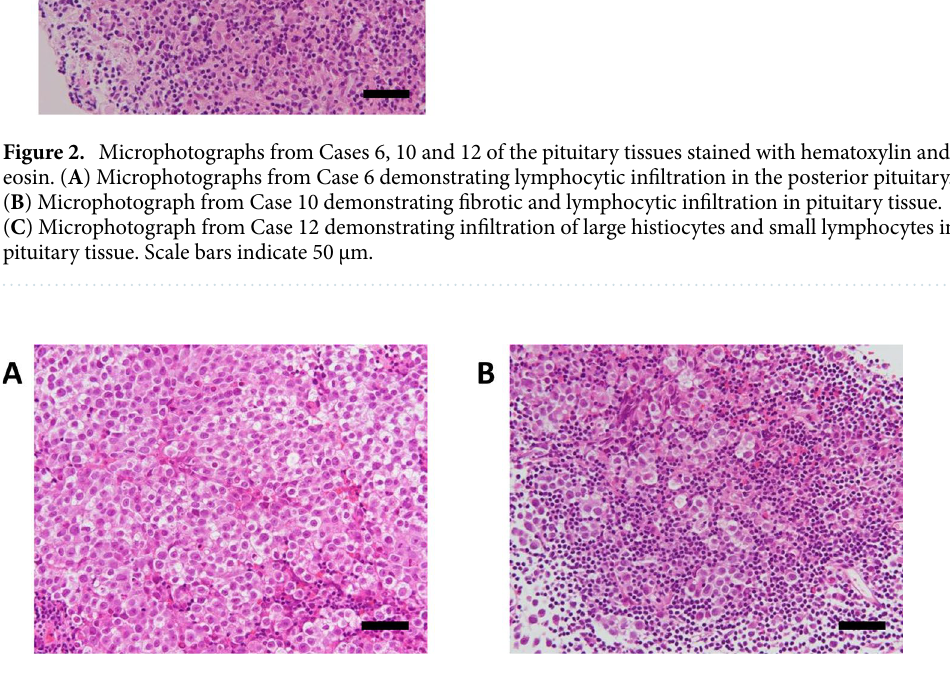
Figure 3. Microphotographs of germinoma tissues stained with hematoxylin and eosin from Case 13. ( A ) Microphotograph of the region in which tumor cells were predominant. ( B ) Microphotograph of the region in which lymphoplasmacytic infiltration was predominant. Scale bars indicate 50